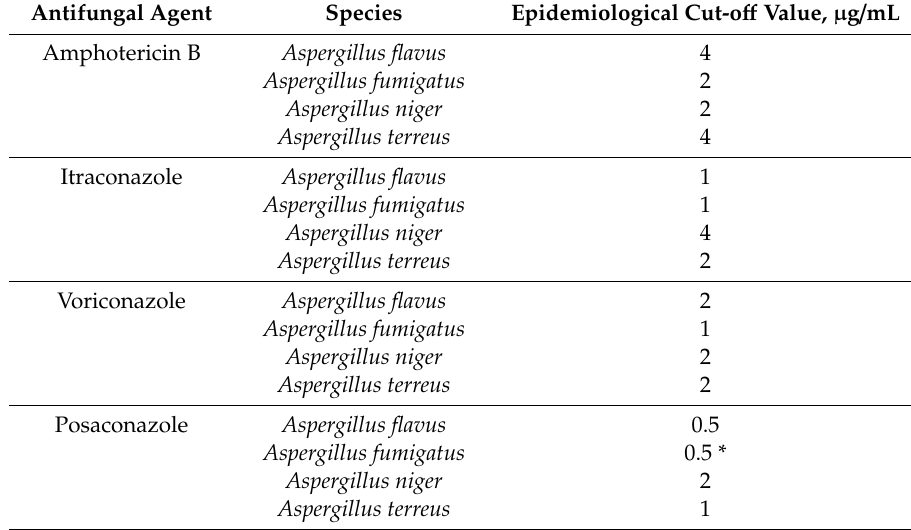
Table 1. Cut-o ff values of the antifungals studied for the di ff erent Aspergillus species according to CLSI M59 2nd Ed.